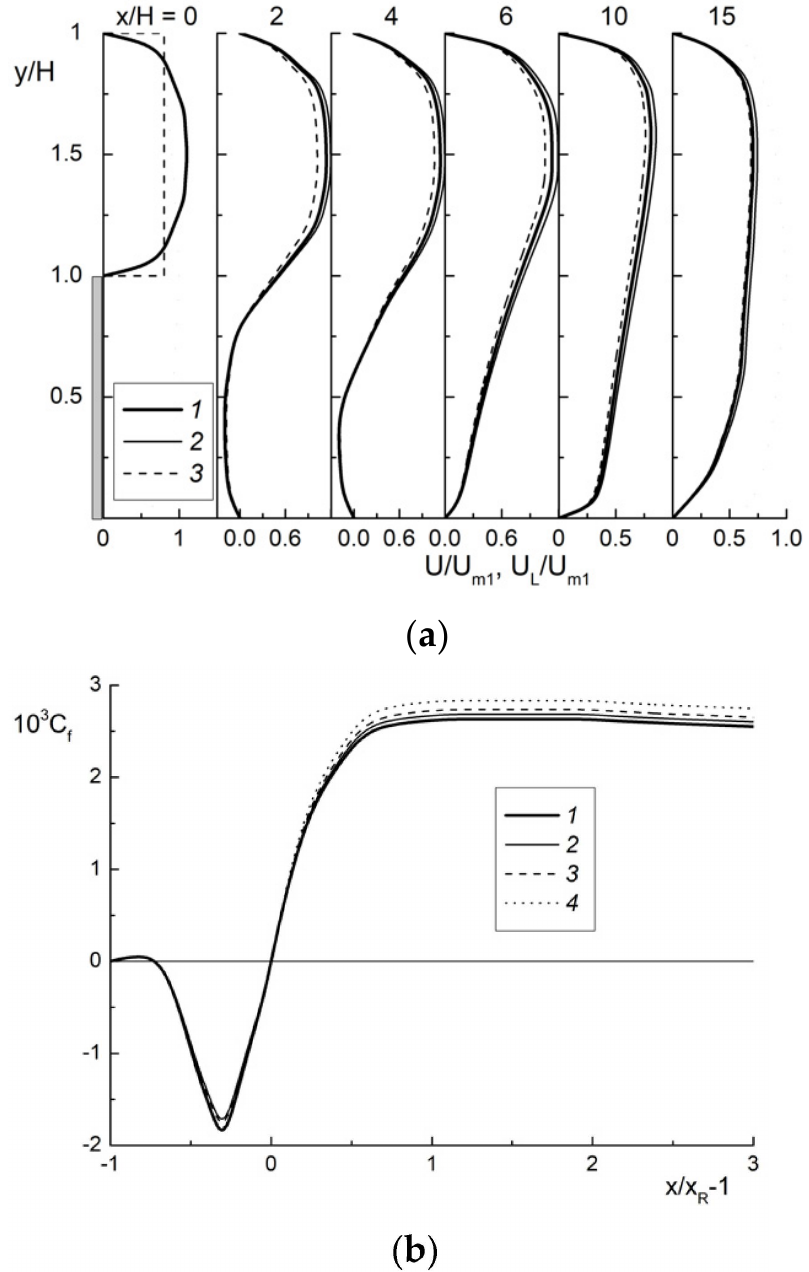
Figure 2. The transverse profiles of ( a ) the mean streamwise phase velocities and distributions of wall friction coefficient along the longitudinal coordinate. d 1 = 30 µ m. ( a ): 1 and 2 are single- phase ( M L 1 = 0) and gas-droplet ( M L 1 = 0.05) flows, respectively; 3 is droplets. ( b ): 1 : M L 1 = 0 (single-phase flow); 2: 0.02; 3: 0.05; 4: 0.1. The wall friction coefficient ( C f = 2 τ W / U 2 ) distributions along the streamwise coordi- 1 nate ( x − x R ) / x R = x / x R − 1 are presented in Figure 2b, where τ W is the shear wall friction and x R is the recirculation length. The line 1 represents the simulations for the single-phase flow without droplets and with other identical conditions. The addition of a dispersed